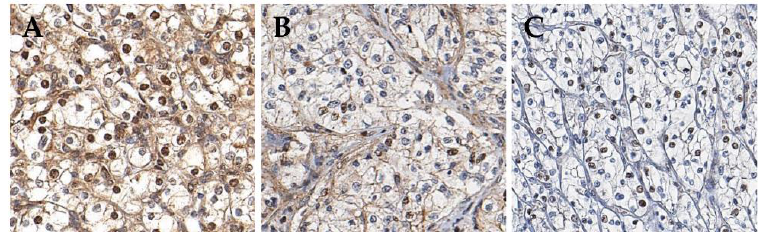
Figure 1. Immunohistochemical staining for pAMPK. ( A ) More than 50% of tumor cells expressed pAMPK both in the cytoplasm and nuclei; ( B ) More than 50% of tumor cells are stained for pAMPK in the cytoplasm but less than 10% of tumor cells show nuclear staining for pAMPK; ( C ) More than 50% of the tumor cells exhibits pAMPK only in the nuclei.